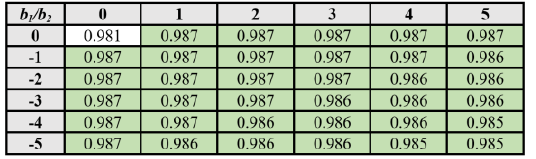
Table 4. Persons 1-10 cumulative sums procedure parameters tuning for coincidence in position and duration of fall segments determined by the procedure and labeled by experts